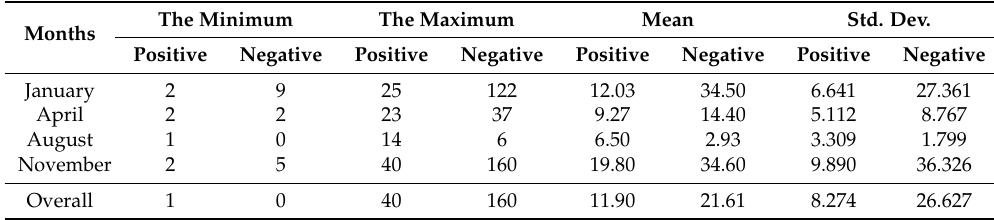
Table 5. Statistics of the emotion indexes in the four sample months.